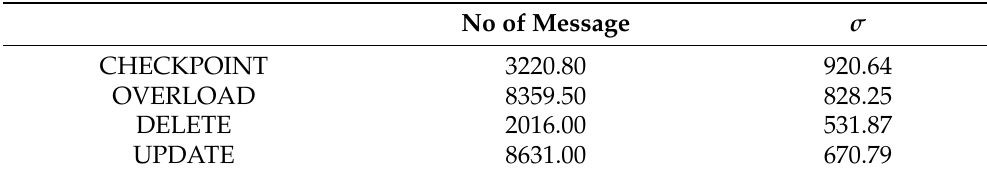
Table 4. The number of messages measured on processing events with mobile nodes following a Gauss–Markov mobility